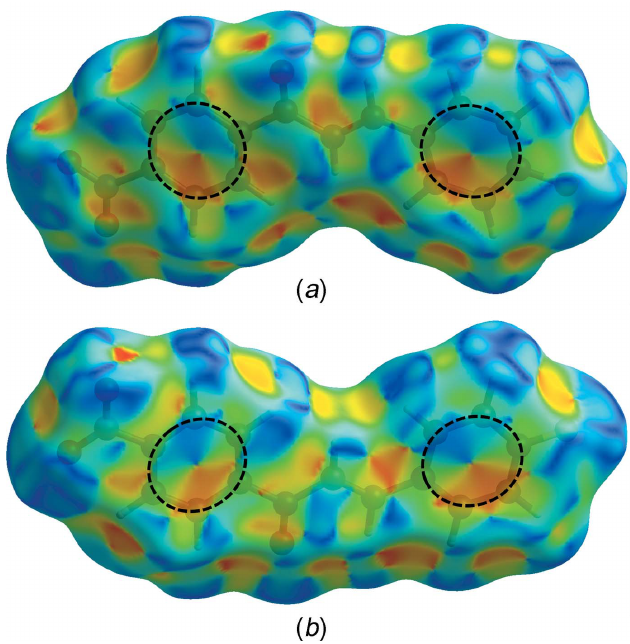
Figure 6 ( a ) Front and ( b ) rear views of the Hirshfeld surface mapped over shape- index for the title compound. The dashed-line circles highlight unique patterns of red and blue